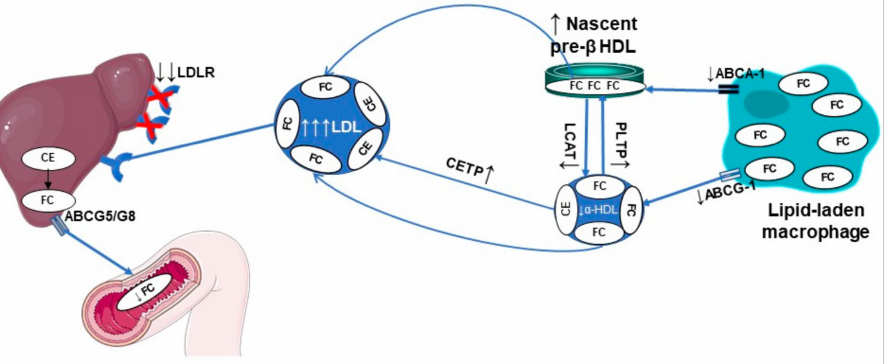
Figure 4. Defective macrophage reverse cholesterol transport in HeFH. ABCA1, ATP-binding cassette transporter A1; ABCG1, ATP-binding cassette transporter G1; ABCG5/G8, ATP-binding cassette transporter G5/G8; Apo, apolipoprotein; CE, cholesteryl ester; CETP, cholesteryl ester transfer pro- tein; FC, free cholesterol; HDL, high-density lipoprotein; LCAT, lecithin: cholesterol acyltransferase; LDL, low-density lipoprotein; LDLR, low-density